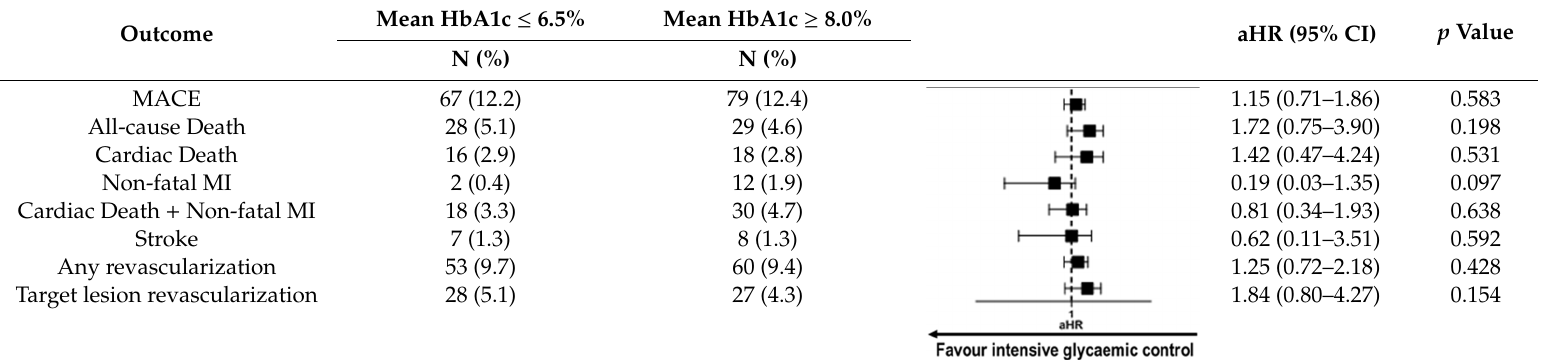
Table 4. The impact of more intensive glycemic control during follow-up on clinical outcome after PCI.